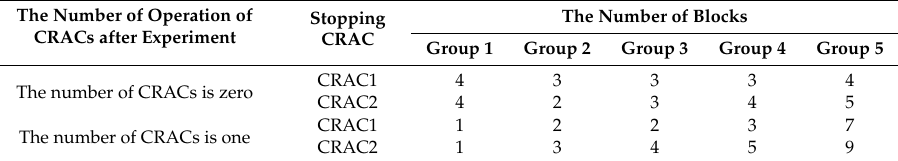
Table 6. Dataset of block for 5-fold cross-validation.